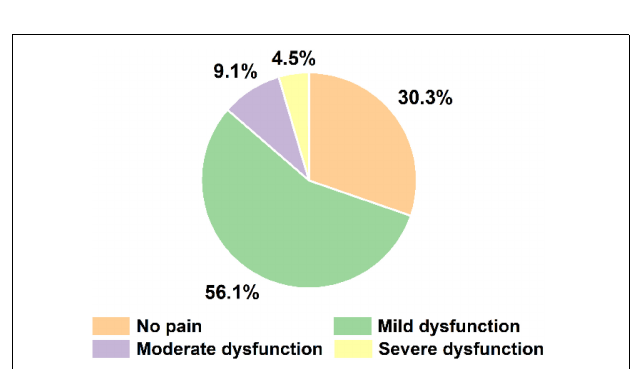
FIGURE 2 | The distribution of subjects with corresponding LBP scale. Complete dysfunction was not applicable to any